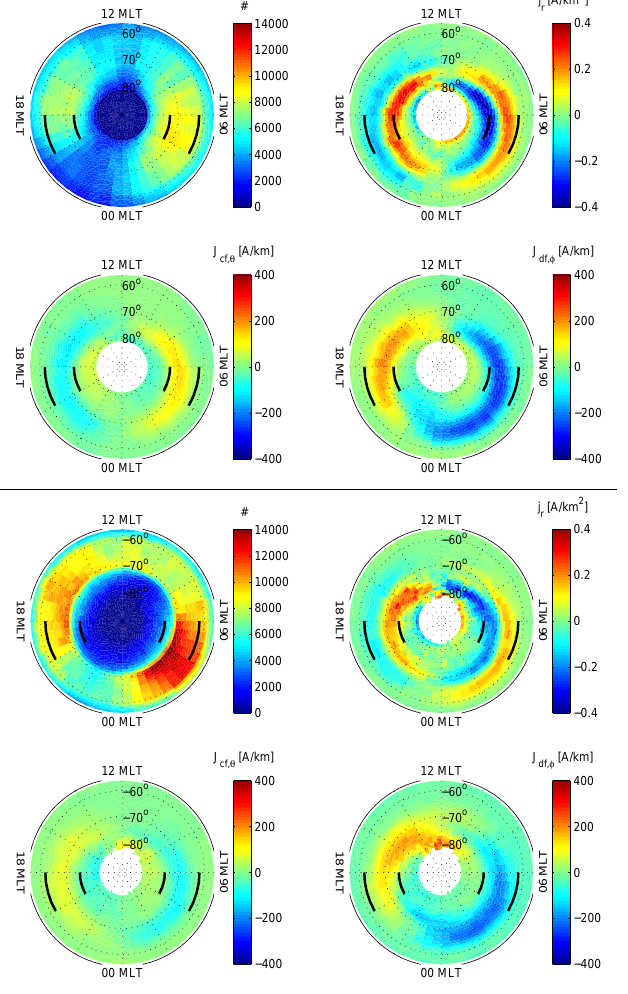
Fig. 3. Ionospheric current density in the northern (top) and in the Southern Hemisphere (bottom): Data point distribution (#), field- aligned current density ( j r , positive up), θ component of the curl- free current density ( J cf,θ , north-south component, positive equa- torward in the Northern Hemisphere and poleward in the Southern Hemisphere), and φ component of the divergence-free current den- sity ( J df,φ , east-west component, positive eastward). The black arcs denote the poleward and equatorward boundaries of the auroral oval as defined in Sect. 2.